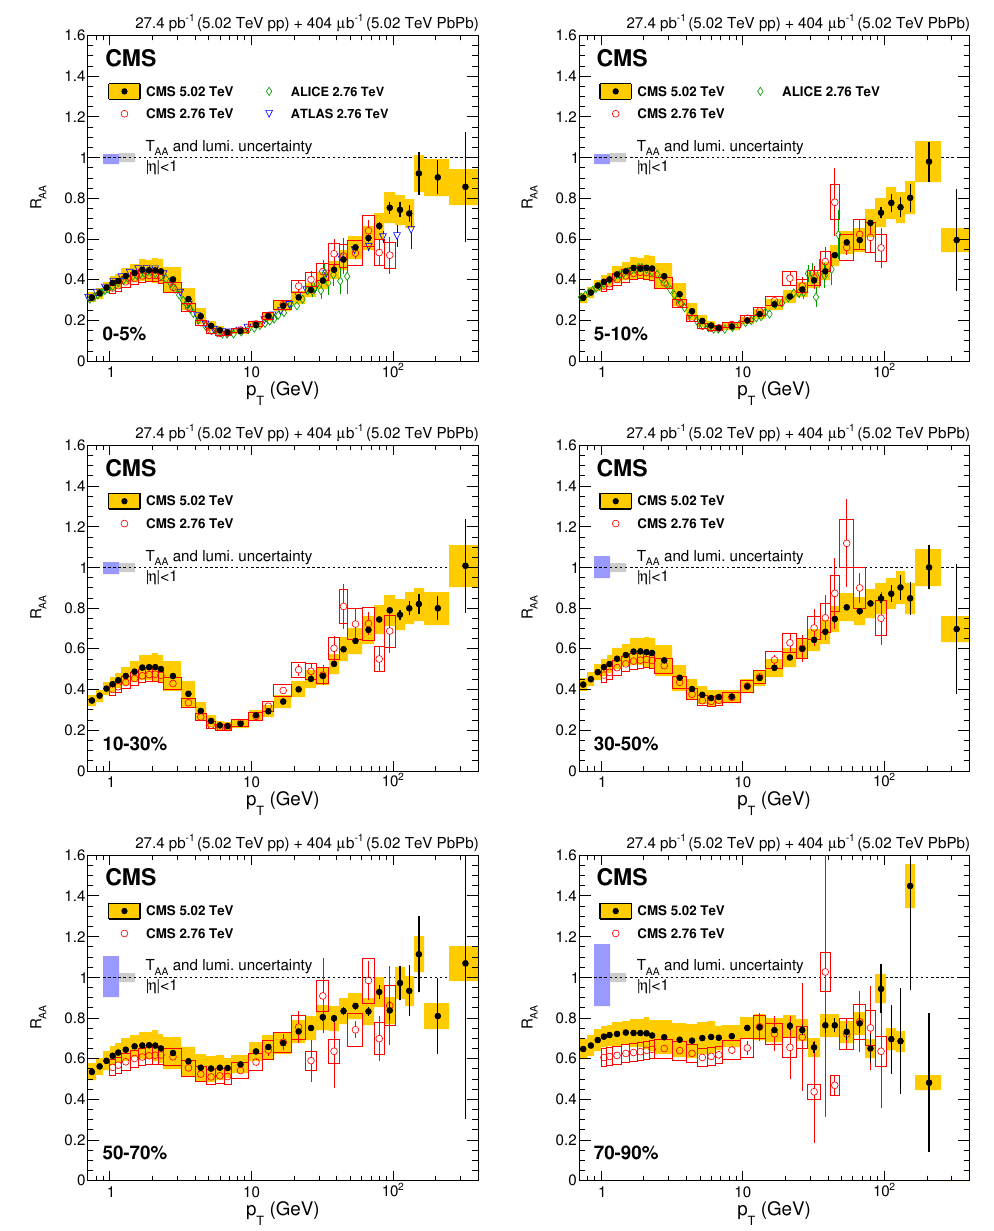
p s NN = 5 : 02 TeV